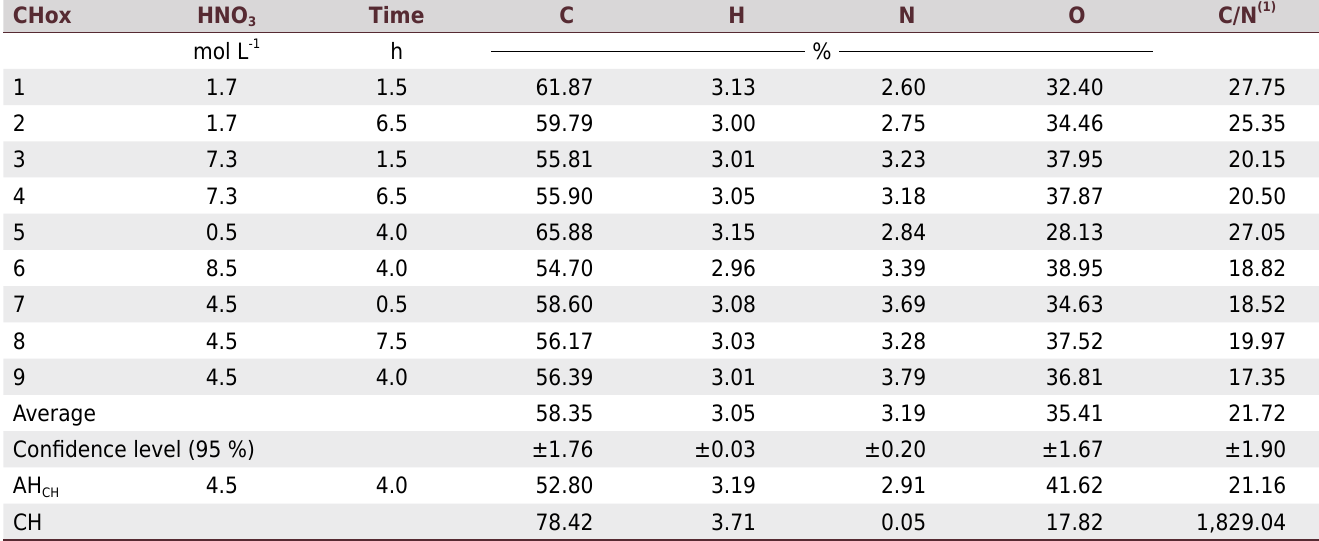
Table 1. Carbon, H, N, and O contents of the nine functionalized charcoals (CHox) obtained according to the concentration of nitric acid and the reaction time of the humic acid obtained from charcoal (AH CH ) and eucalyptus charcoal (CH) as raw materials